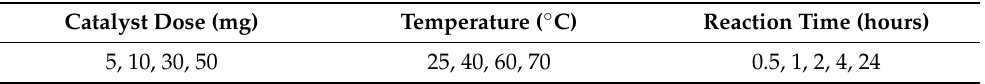
Table 1. Parameters investigated in the oxidation reaction of cyclohexane over bulk NiO using m -CPBA as oxygen